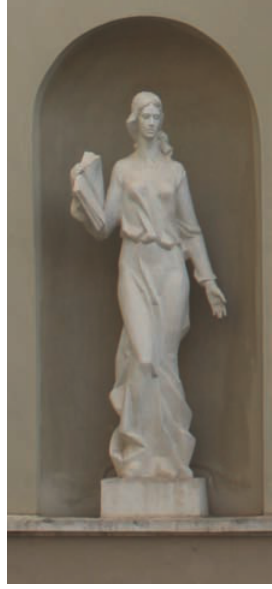
Fig. 2. The orthophoto of an